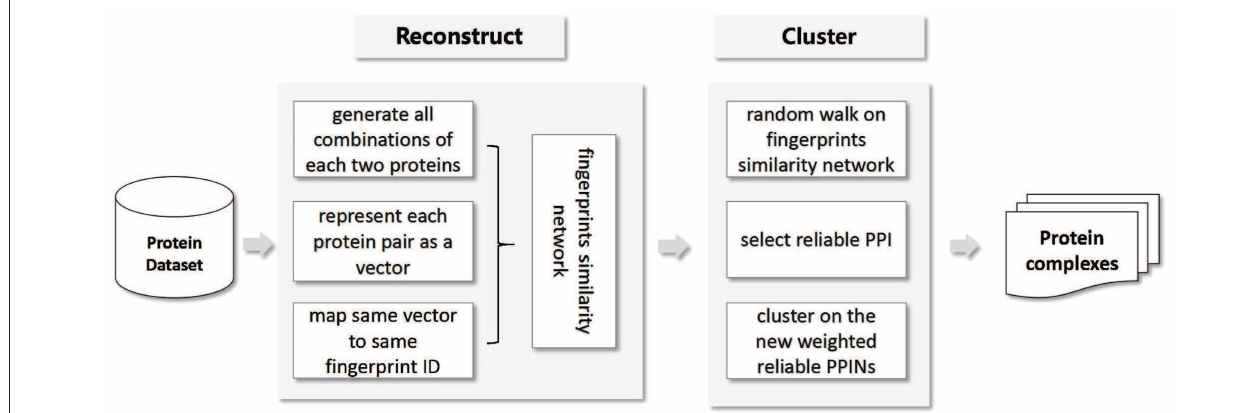
FIGURE 1 | The working flow of our method.